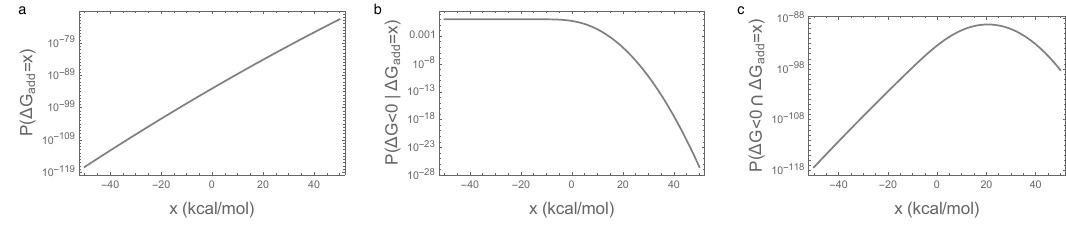
Figure 4. Illustration of the main mechanism behind the essentiality of epistatic interactions for spontaneous folding: ( a ) density of random sequences with given additive free energy P ( ∆ G add = x ) = PDF ( N ( µ 1 , σ 2 ( b ) fraction of sequences that fold given additive free energy P ( ∆ G < 0 | ∆ G add = x ) = CDF ( N ( 0, σ 2 ( c ) density of random sequences that fold and have the given additive free energy P ( ∆ G < 0 ∩ ∆ G add = x ) . Parameters are identical to those in Figure